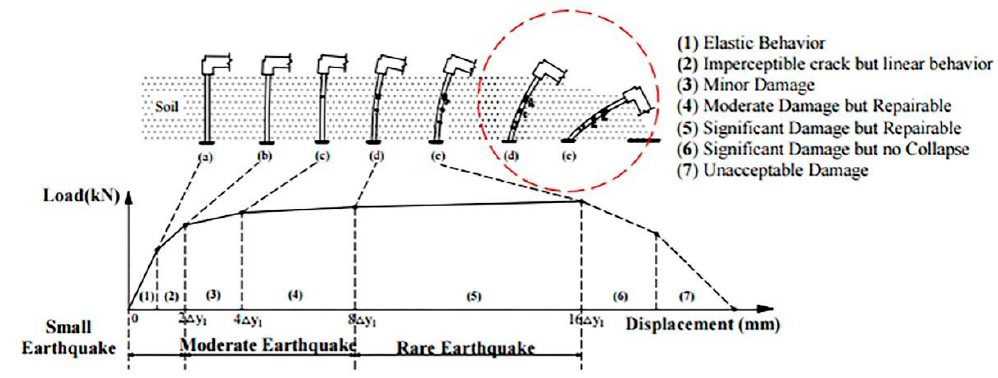
Figure 20. Seismic design criteria of pile foundation.